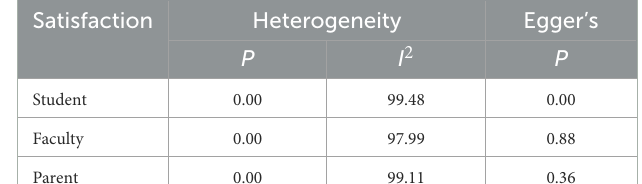
TABLE 4 Heterogeneity and publication bias